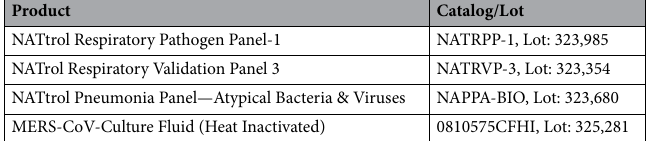
Table 3. Commercially available pathogen panels for cross-reactivity wet testing with SaliVISION assay.